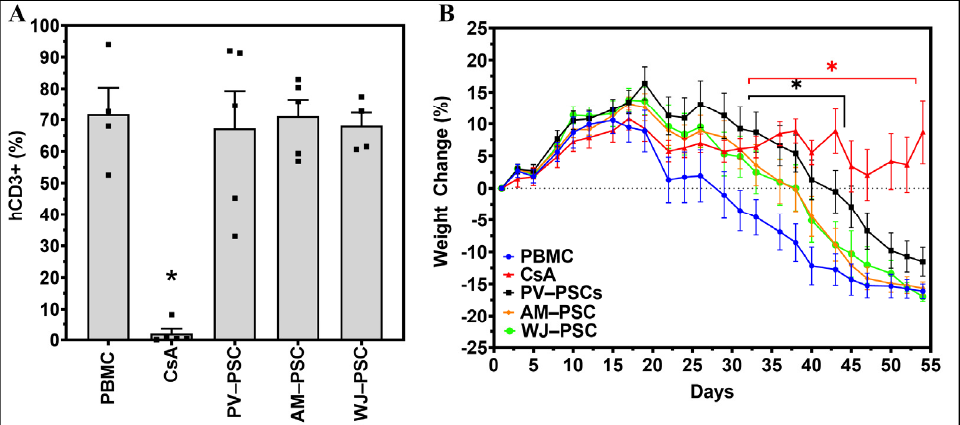
Figure 2. Administration of PV-PSCs delay weight loss in the progression of GvHD. ( A ) Population of human CD3+ present in mice at Day 40 indicative of the presence of the GvHD disease state. ( B ) Daily percent weight change per experimental condition with last carried observation carried over included for weight in cases of animal death. A two-way ANOVA test for the change in weight with time and treatment was performed and denoted as significant at * p < 0.05. PBMC and cyclosporin A are the respective positive (GvHD) and negative (attenuated GvHD) controls. Abbreviations: human peripheral blood mononucleated cells (huPBMC), human perinatal stromal cells (huPSCs), amniotic perinatal stromal cells (AM-PSC), placental villi perinatal stromal cells (PV-PSC) and Wharton’s jelly perinatal stromal cells (WJ-PSC).